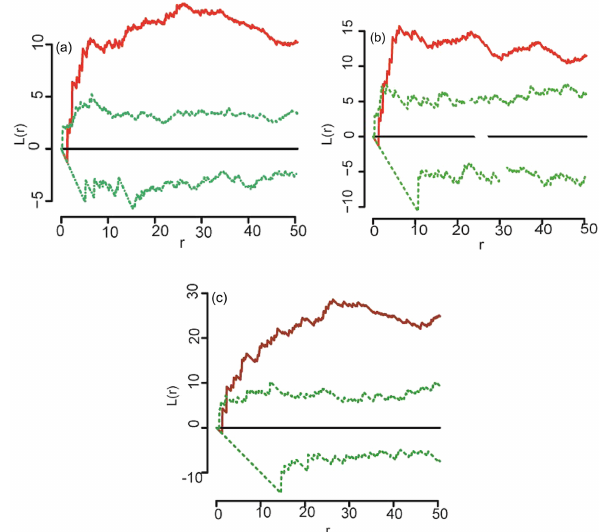
Figure 3. Ripley’s L(r) functions and Monte Carlo intervals for elm trees in different classes. Observed patterns (red color, straight line) fell above, below and within 95% Monte Carlo intervals (green color, dashed line). The spatial pattern of all elm trees with DBH ≥ 10cm in the grazed plot was shown in (a) . The spatial patterns of elm with two classes in the grazed plot were shown in (b) 10cm ≤ DBH ≤ 15cm and (c) 15cm < DBH ≤